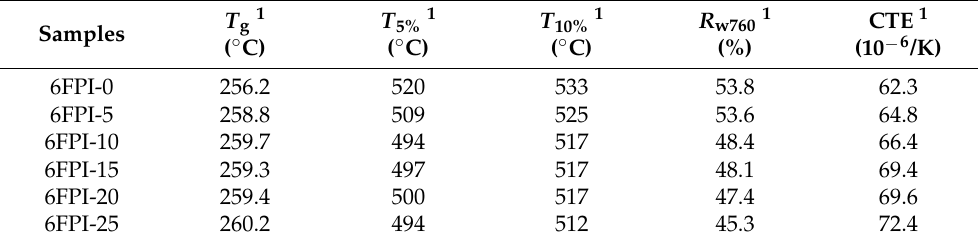
Table 3. Thermal properties of the 6FPI/POSS composite films.